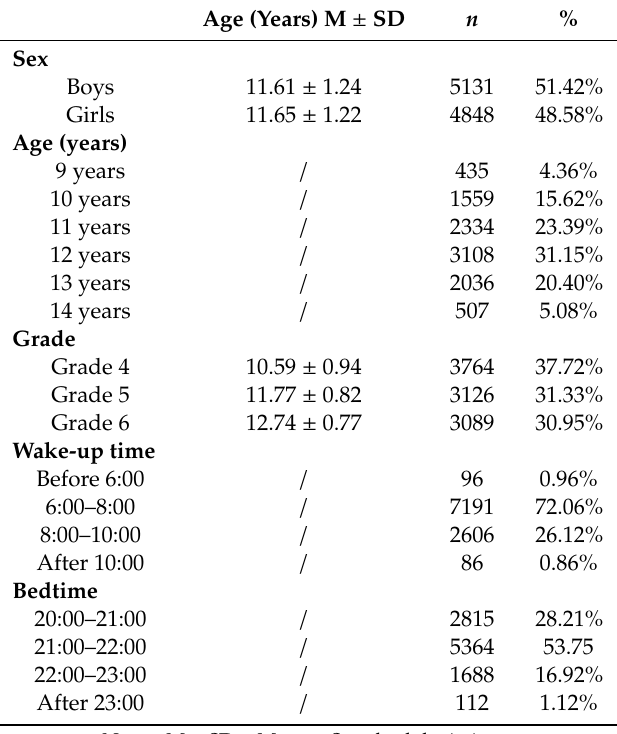
Table 1. Descriptive characteristics of study subjects ( N =